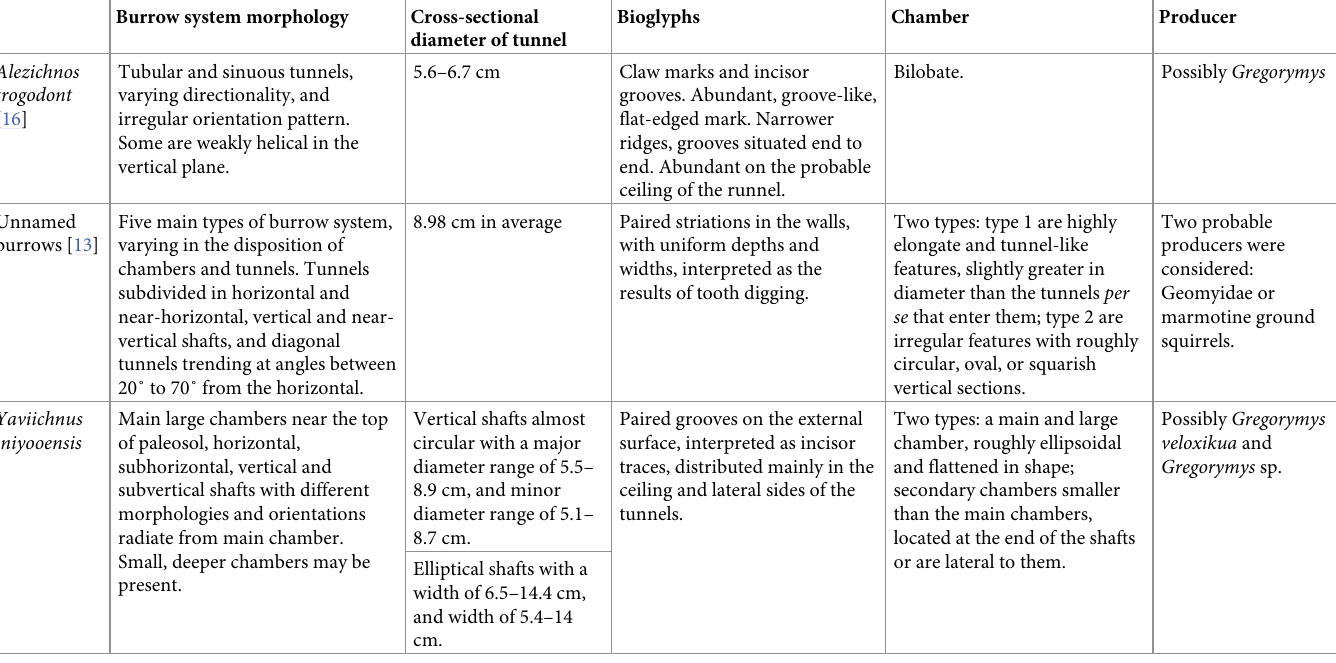
Table 1. Main features of fossil burrow systems probably produced by geomyidae. Burrow system